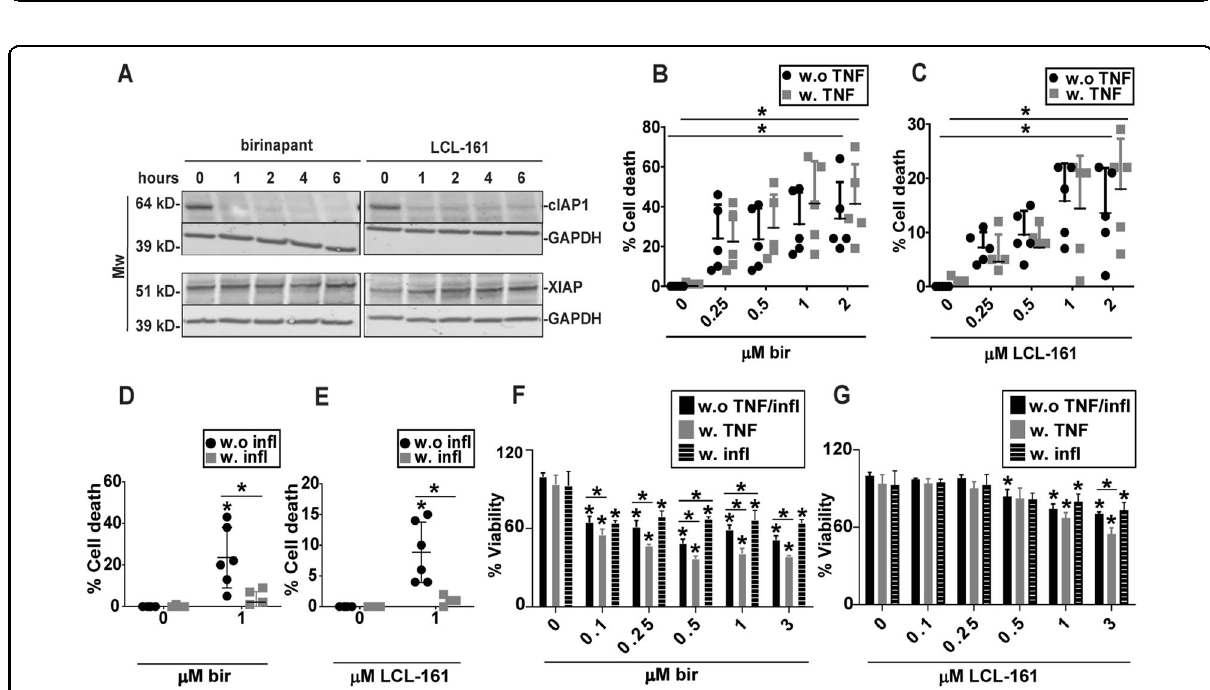
Fig. 2 Birinapant and LCL-161 trigger TNF-dependent cell death in pre-OC. Pre-OC were treated with 1 μ M birinapant or LCL-161 at the indicated time points, and cell lysates were analyzed for cIAP1 and XIAP protein levels by immunoblotting. GAPDH is loading control, shown for corresponding membranes. One representative of three donors is shown ( A ). Pre-OC were treated with birinapant ( B ) or LCL-161 ( C ) alone or in combination with 25ng/ml TNF for 18h and analyzed for cell death. 5 donors, mean, and SD are shown. Pre-OCs were treated with 1 μ M of birinapant ( D ) or LCL-161 ( E ) in combination with the TNF-blocking antibody in fl iximab (0.1 μ g/ml) and analyzed for cell death. Cell death was measured by LDH- release ( B – E ), 6 donors, mean and are shown ( D – E ). Viability of hOCP after treatment with indicated concentrations of LCL-161 ( F ) and birinapant ( G ) alone or in combination with 25ng/ml TNF for 18h. Results are technical triplicates from one experiment. Cell viability was measured with the Cell Titer Glo assay. Asterisks indicate groups signi fi cantly different from control ( B , C , F , G ) or between indicated groups ( D , E , F , G ) ( p < 0.05, One-way